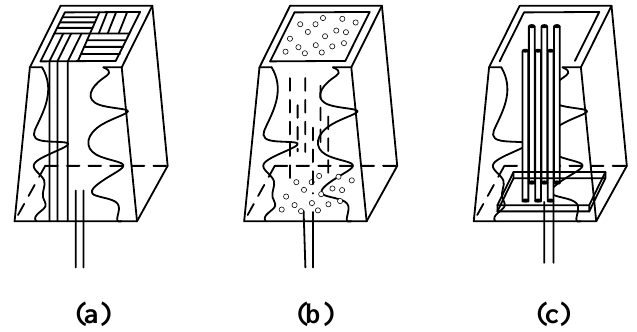
Figure 7. The structure of different brick elements. ( a ) gap type combined brick, ( b ) straight hole type, ( c ) porous plug brick (MHP).